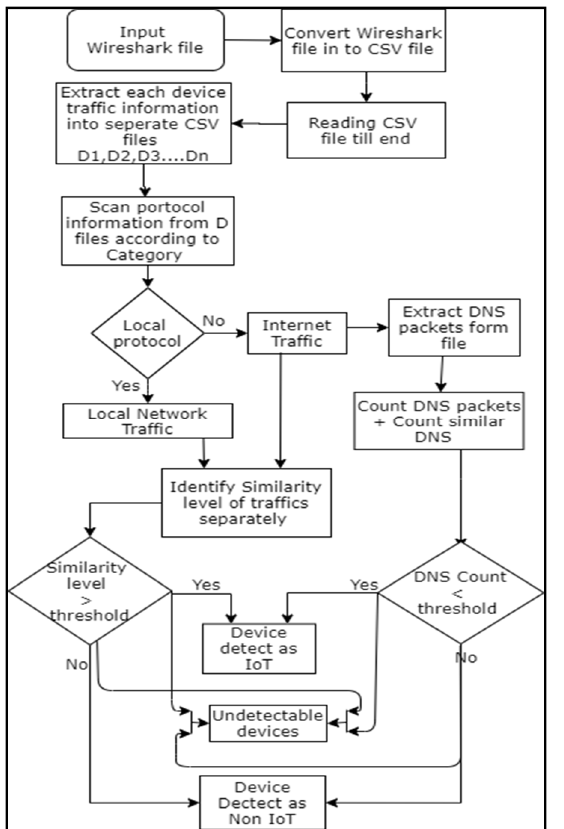
Fig. 4: Proposed Methodology